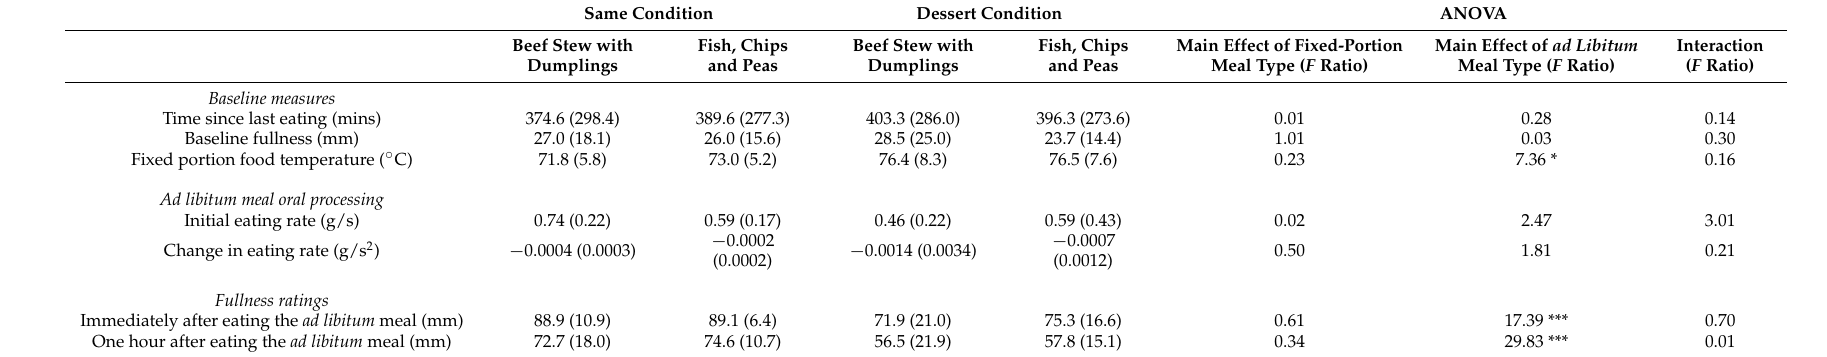
Table 5. Mean ( ˘ S.D.) scores for baseline measures, ad libitum meal oral processing and fullness after the ad libitum